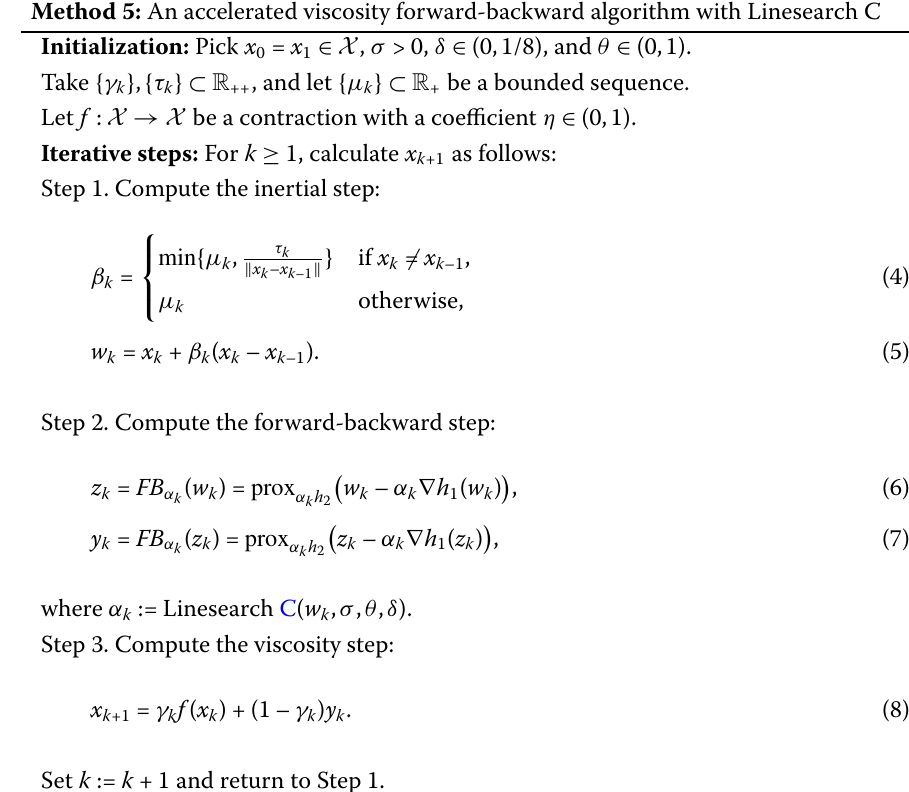
Method 5: An accelerated viscosity forward-backward algorithm with Linesearch